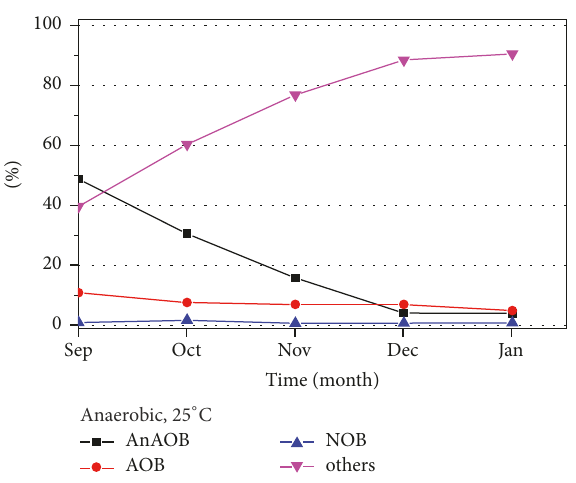
Figure 5: Proportion variation of species in the total functional microbial communities under anaerobic condition.